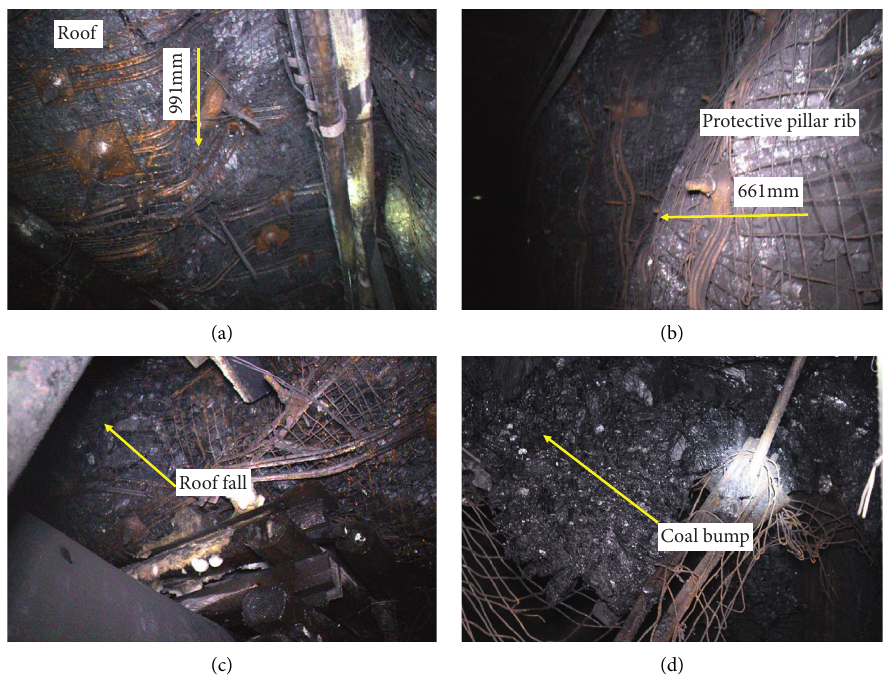
Figure 6: Failure characteristics of 8102 headgate. (a) Roof sagging. (b) Protective pillar bulging. (c) Roof fall. (d) Coal bump.